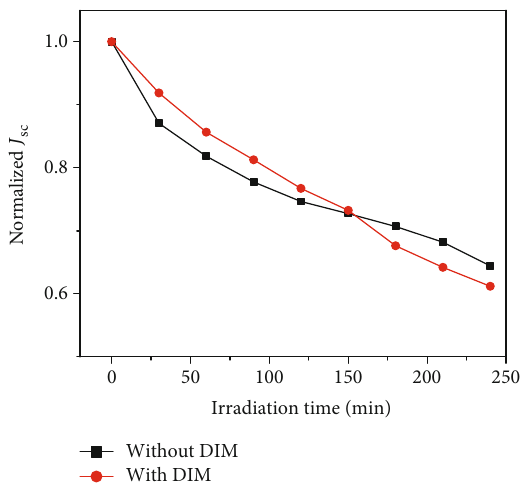
Figure 7: Normalized J sc of the PCDTBT:PC 71 BM solar cell processed without and with 3% DIM as a function of irradiation (100mW/cm 2 ) time at ambient air.